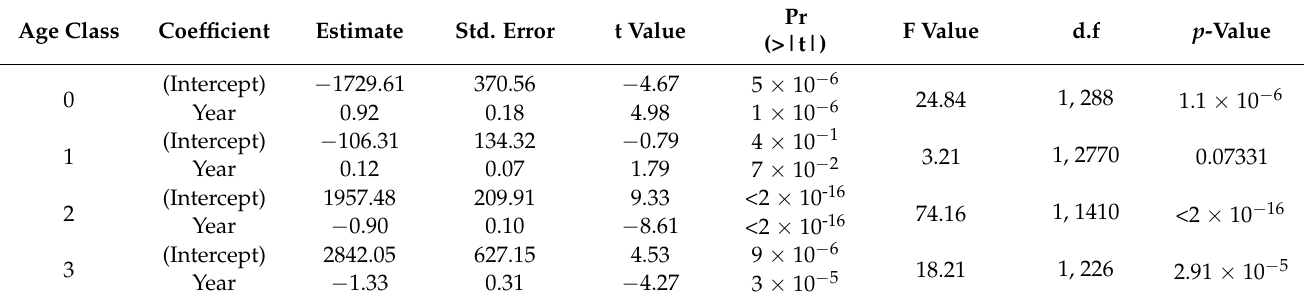
Figure 4. Temporal trend in the average length (Total length, TL in mm) per age class during the study period. Table 3. Linear regression carried out to detect TL trends among years by Age. Estimated coe ffi cients for each linear regression model were provided together with the F statistics for each age class.